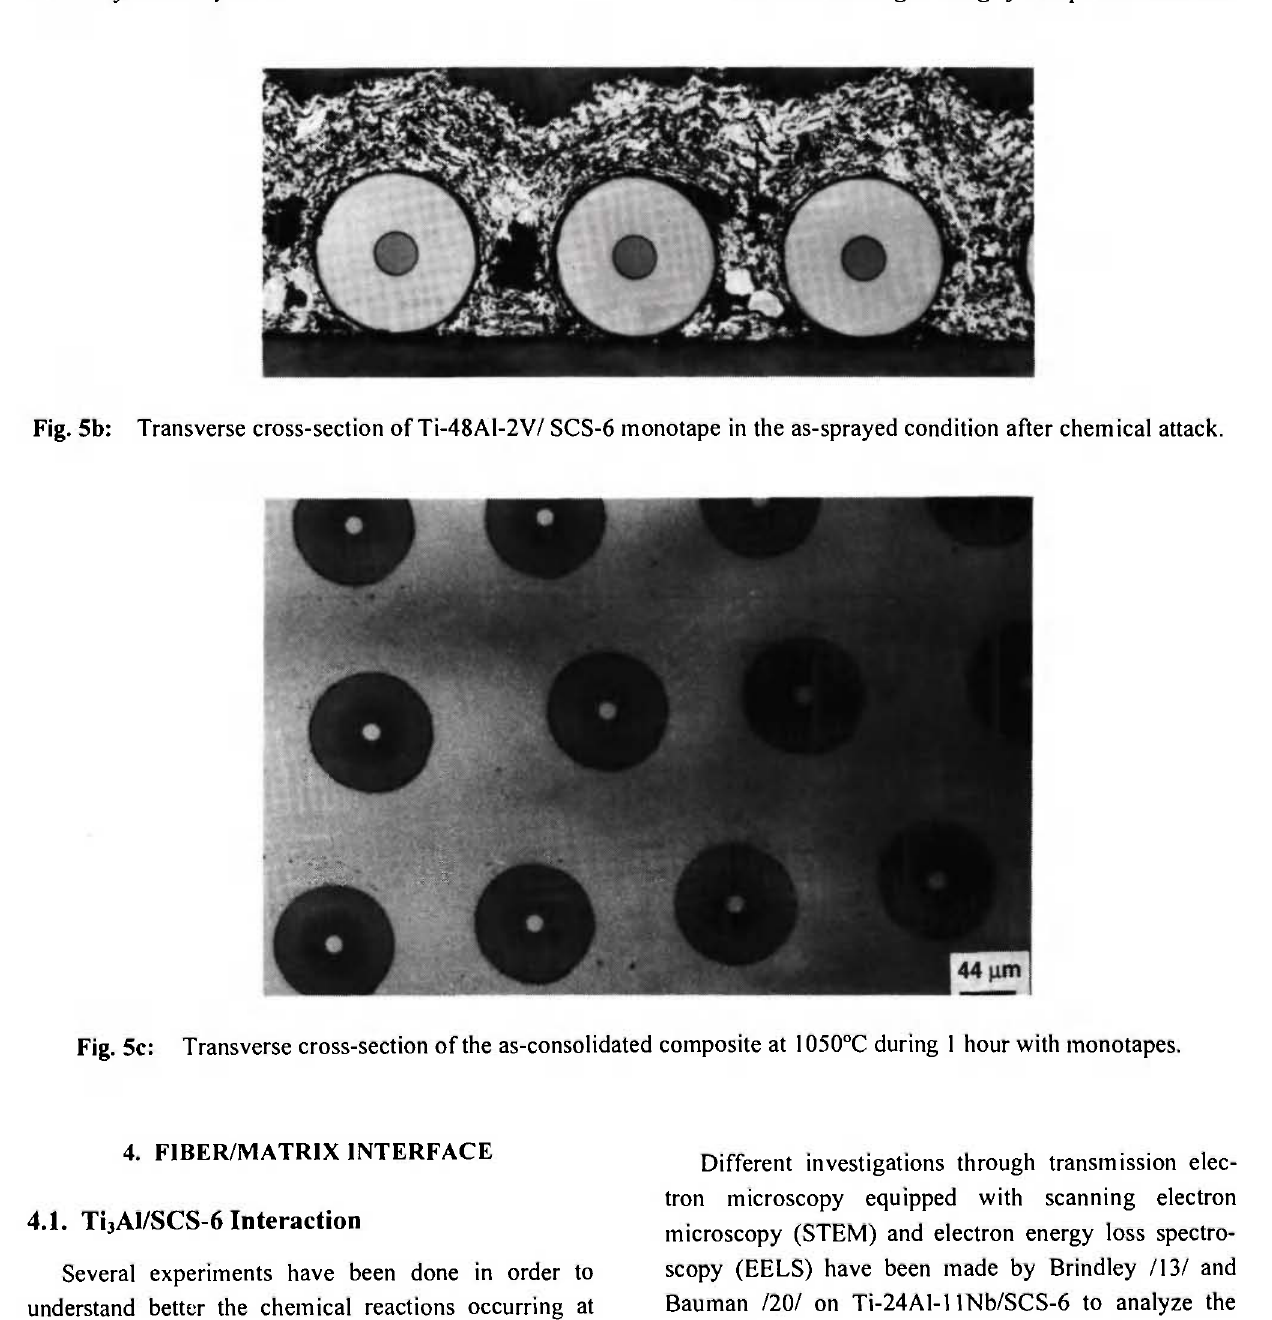
Fig. 5c: Transverse cross-section of the as-consolidated composite at 1050°C during 1 hour with